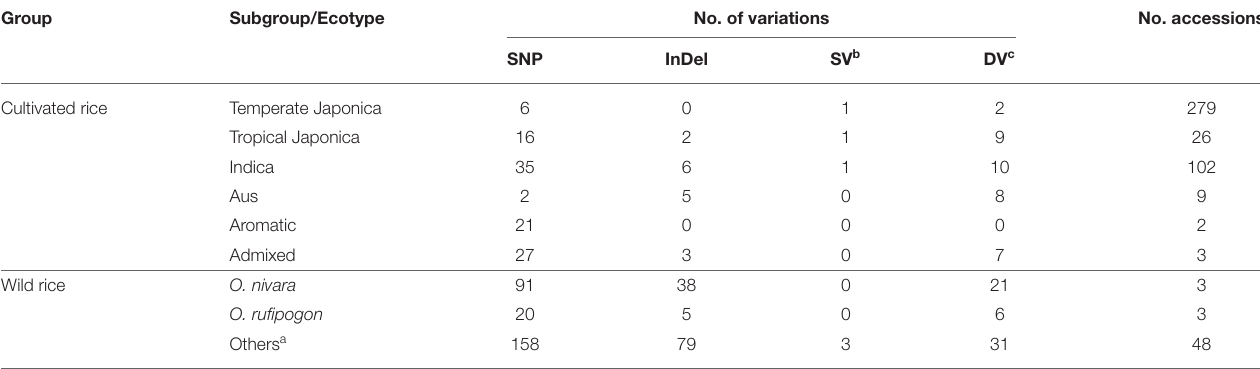
TABLE 1 | Summary of genetic variations in the granule-bound starch synthase I ( GBSSI ) gene region of 475 accessions from the Korean rice collection. Group